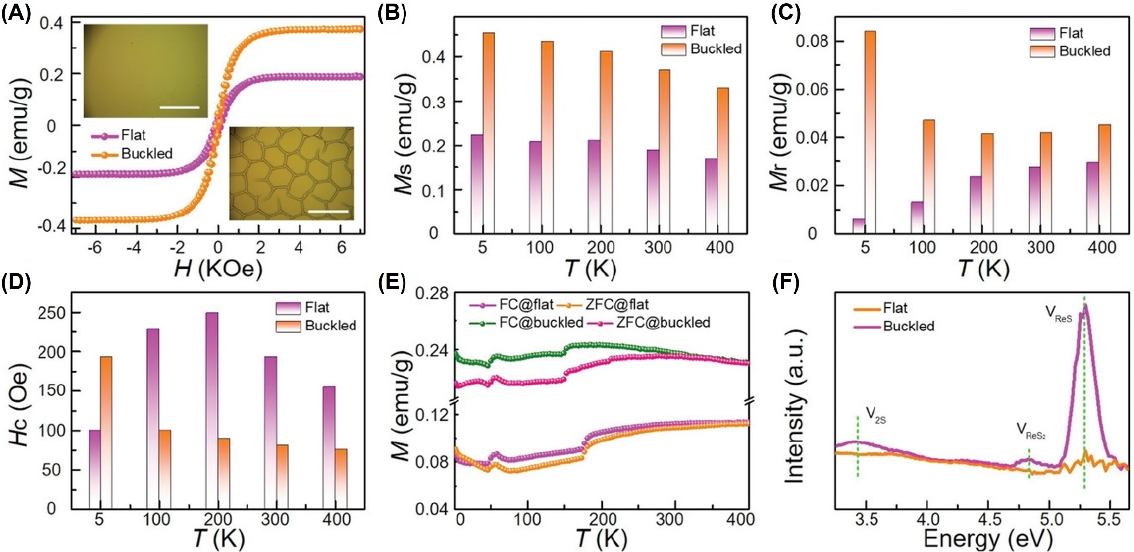
Figure 11. Ferromagnetism of ReS 2 thin films. ( A ) M − H curves at 300 K. Scale bar: 50 µm. ( B − D ) M s − T , M r − T, and H c − T , respectively. ( E ) FC and ZFC curves from 2 to 400 K. ( F ) FL curves. Reprinted with permission from [27]. Copyright 2019, John Wiley and Sons.